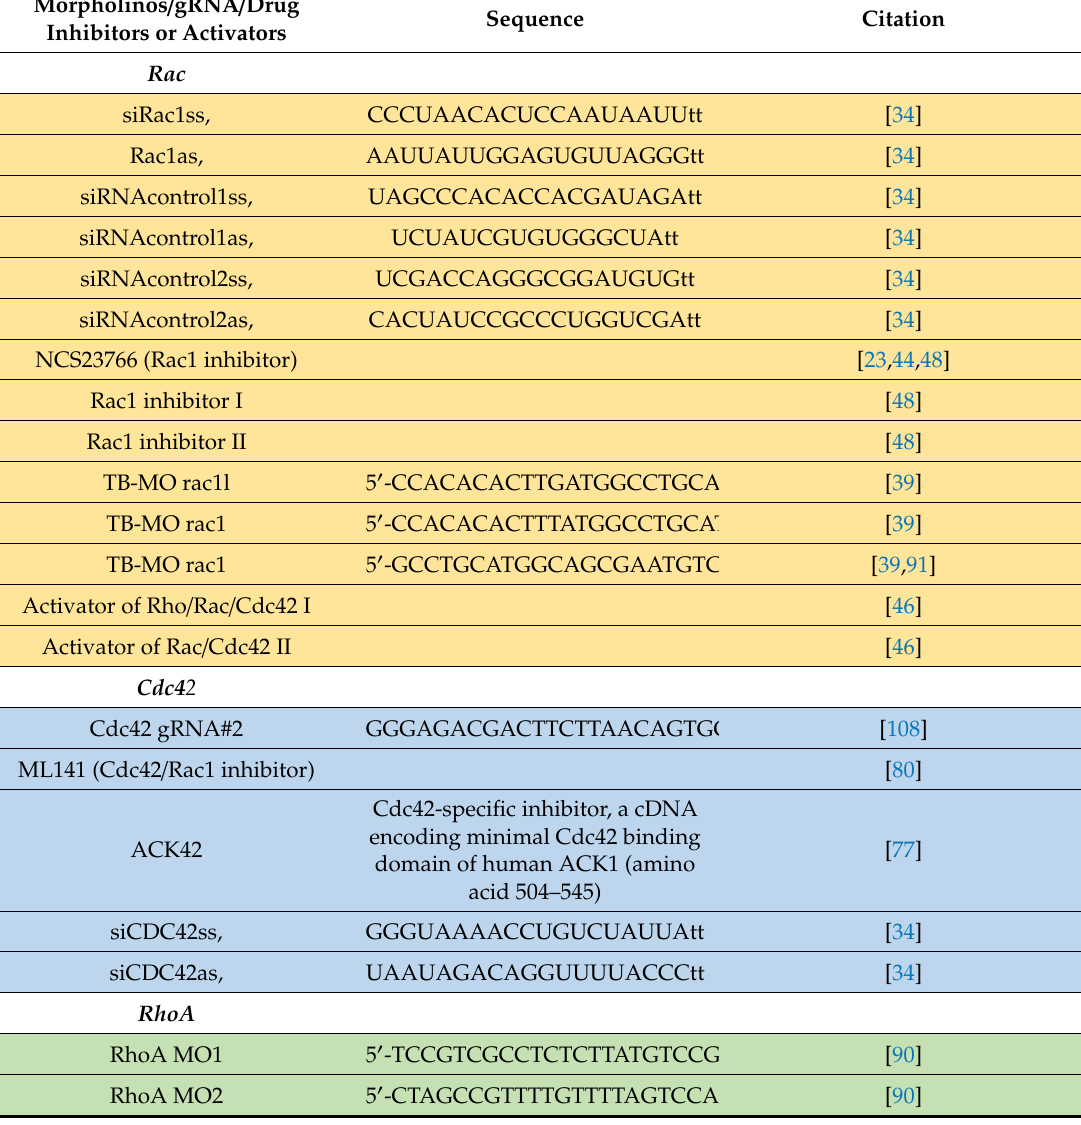
Table 3. Available morpholinos (MOs) and tools to activate or inhibit Rho GTPases activity in zebrafish. Morpholinos / gRNA / Drug Inhibitors or